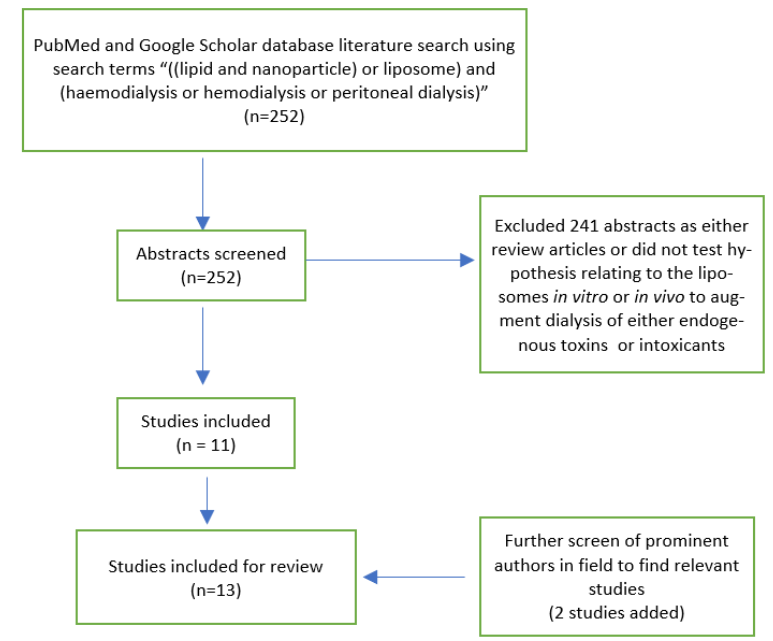
Figure 1. PRISMA diagram of studies included in this